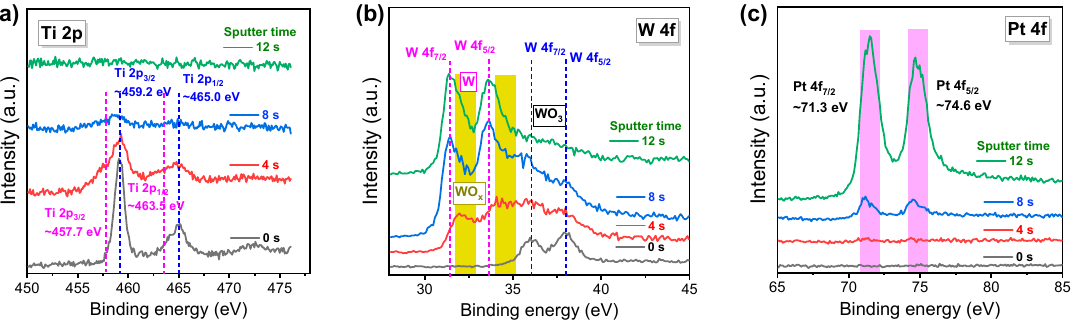
Figure 1. XPS spectra of ( a ) Ti 2 p , ( b ) W 4 f , and ( c ) Pt 4 f in TiO 2 (6 nm)/WO x (10 nm)/Pt stack.